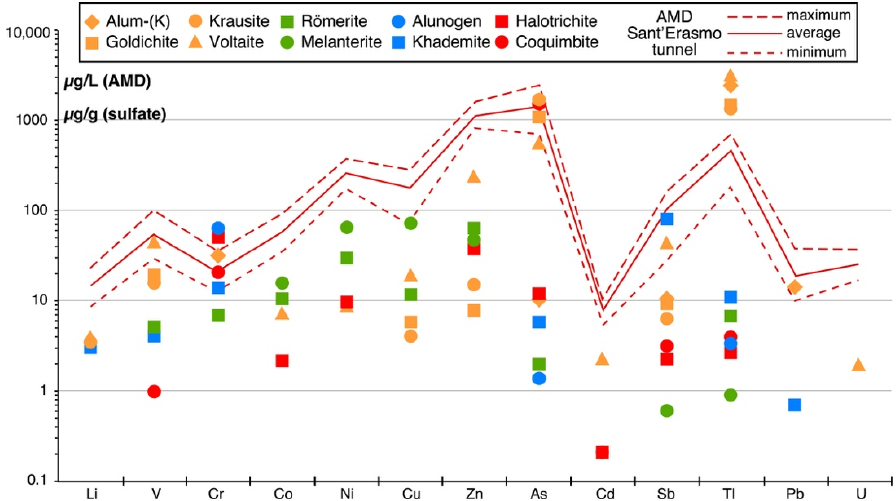
Figure 7. Concentrations (in μ g/g) of trace elements in the studied sulfates, along with concentrations (in μ g/L) of the same elements in the acid mine drainage (AMD) from the Sant’Erasmo tunnel (Monte Arsiccio mine). The AMD concentrations are taken from [12] and represent the maximum, minimum, and average values measured over the period 2014–2016.